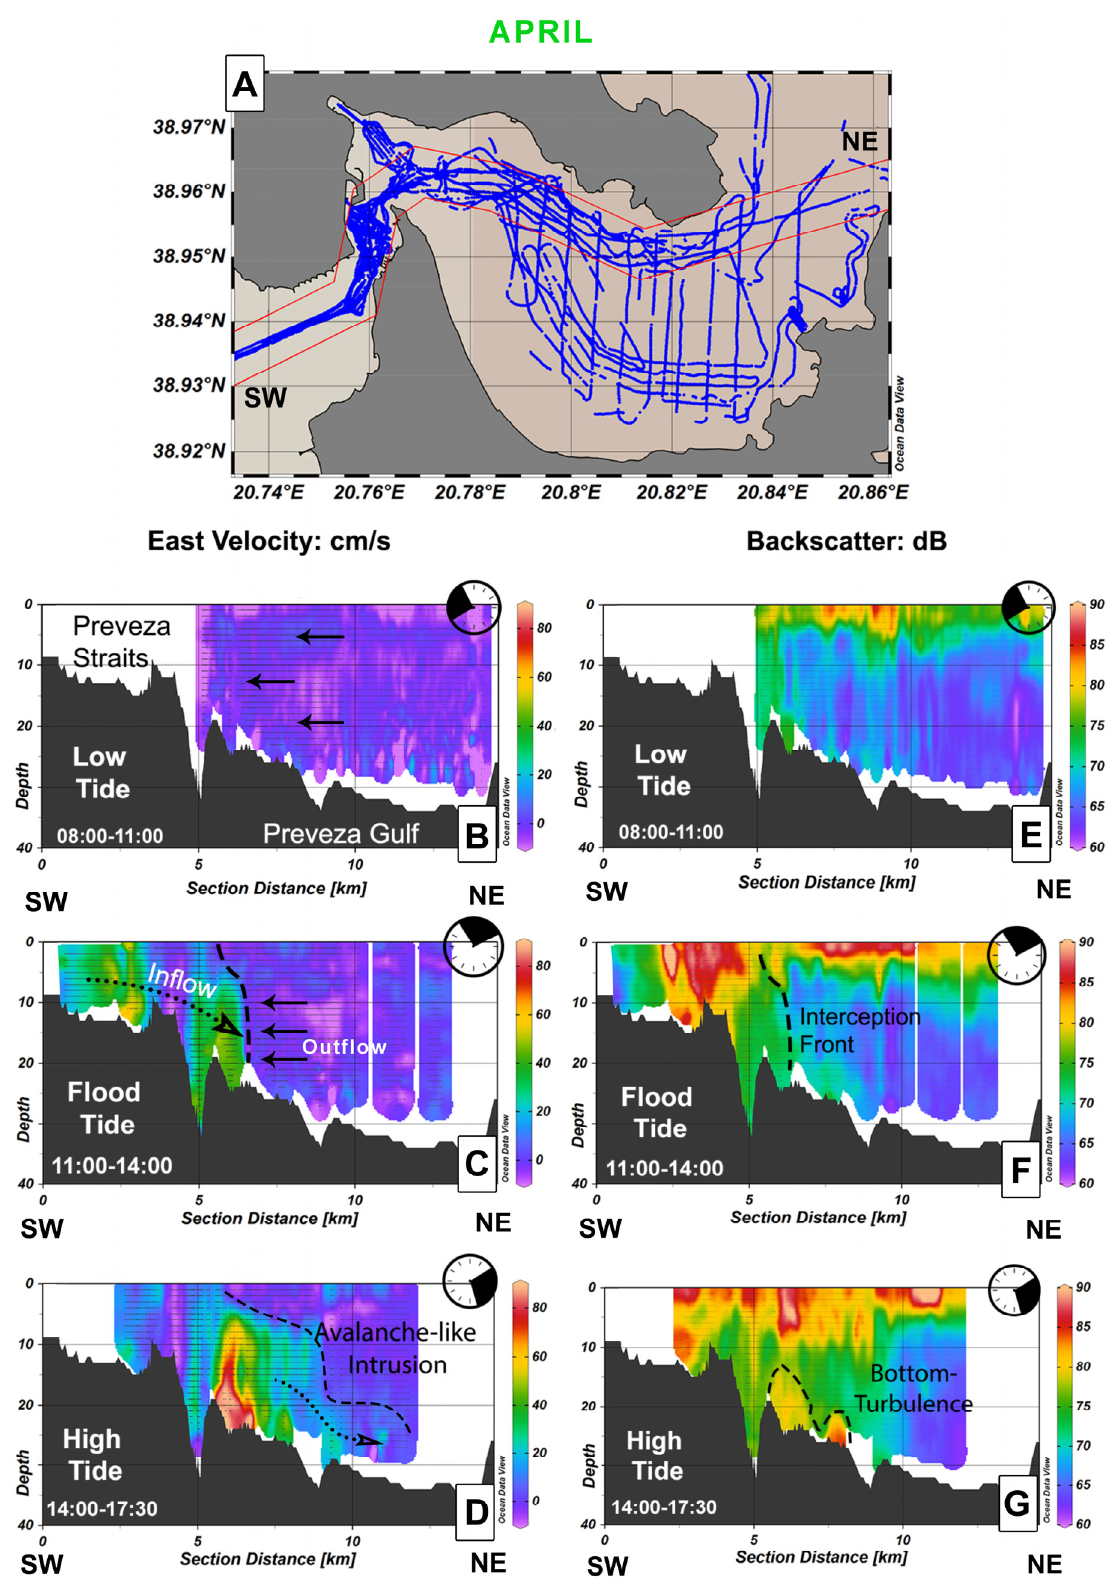
Figure 3. ( A ) ADCP data (blue dots) in April at the sill and section location (red polygon- averaged values of ADCP data), ( B – D ) SW-NE sections describing the tidal intrusion as monitored by the ADCP showing the eastern velocity (cm/s) during different time steps based on the tide fluctuation, and ( E – G ) relative backscatter intensity